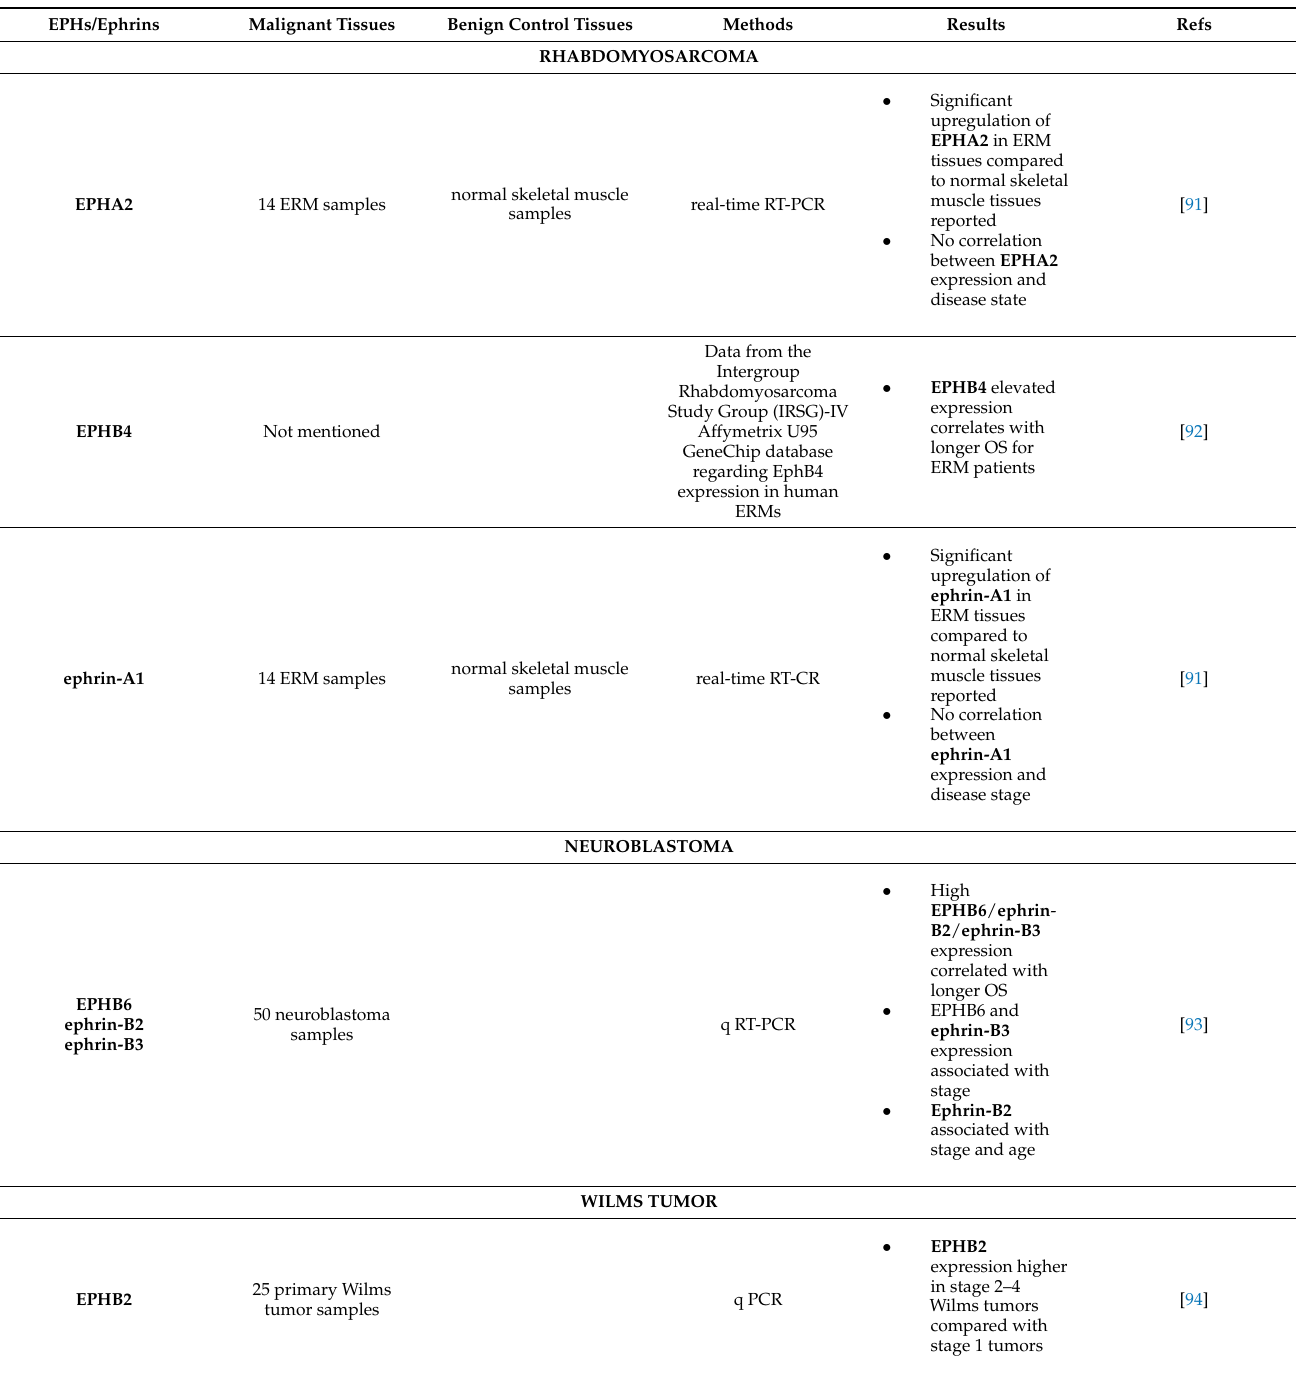
Table 6. EPHs/ephrins (bold) studied in solid pediatric tumors and correlations with clinicopathological parameters.